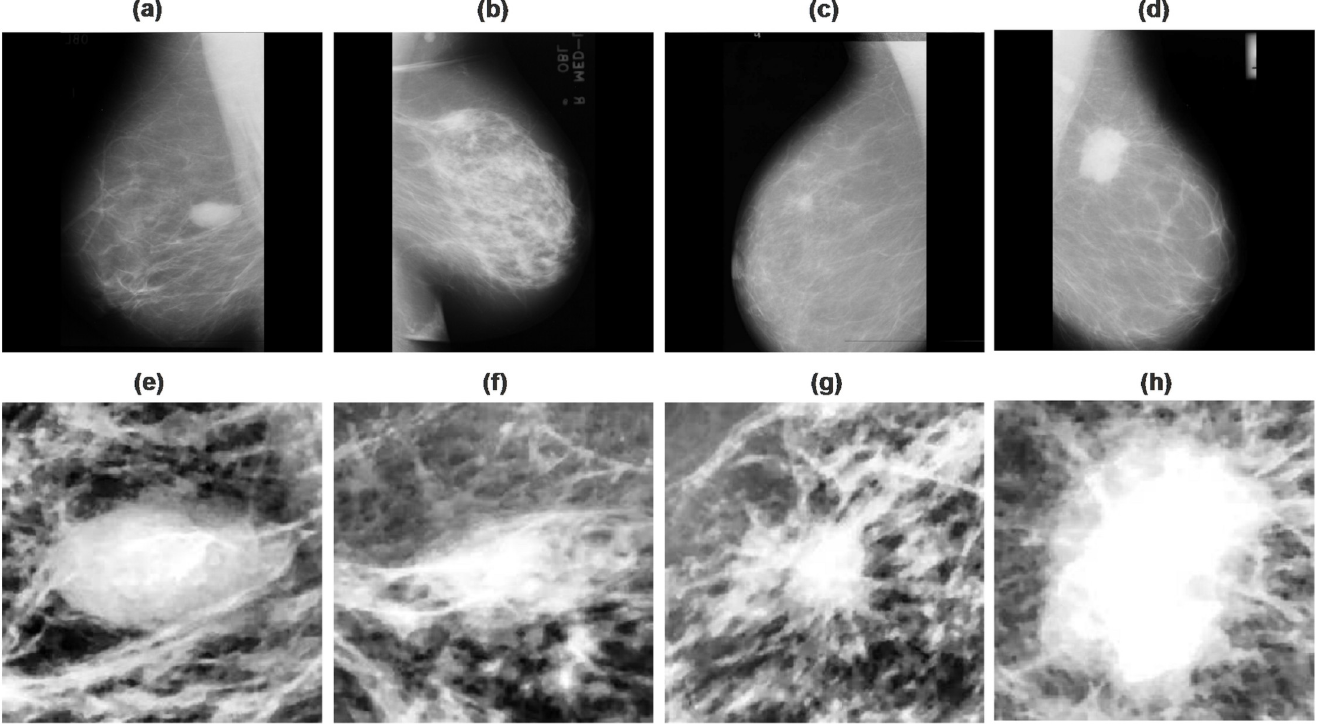
Fig 1. Few samples of digitized mammography images collected from the MIAS dataset. (a-b) are benign tumors, (c-d) malignant tumors, (e-f) sample of extracted ROIs of benign tumors, (g-h) extracted ROIs of malignant tumors.